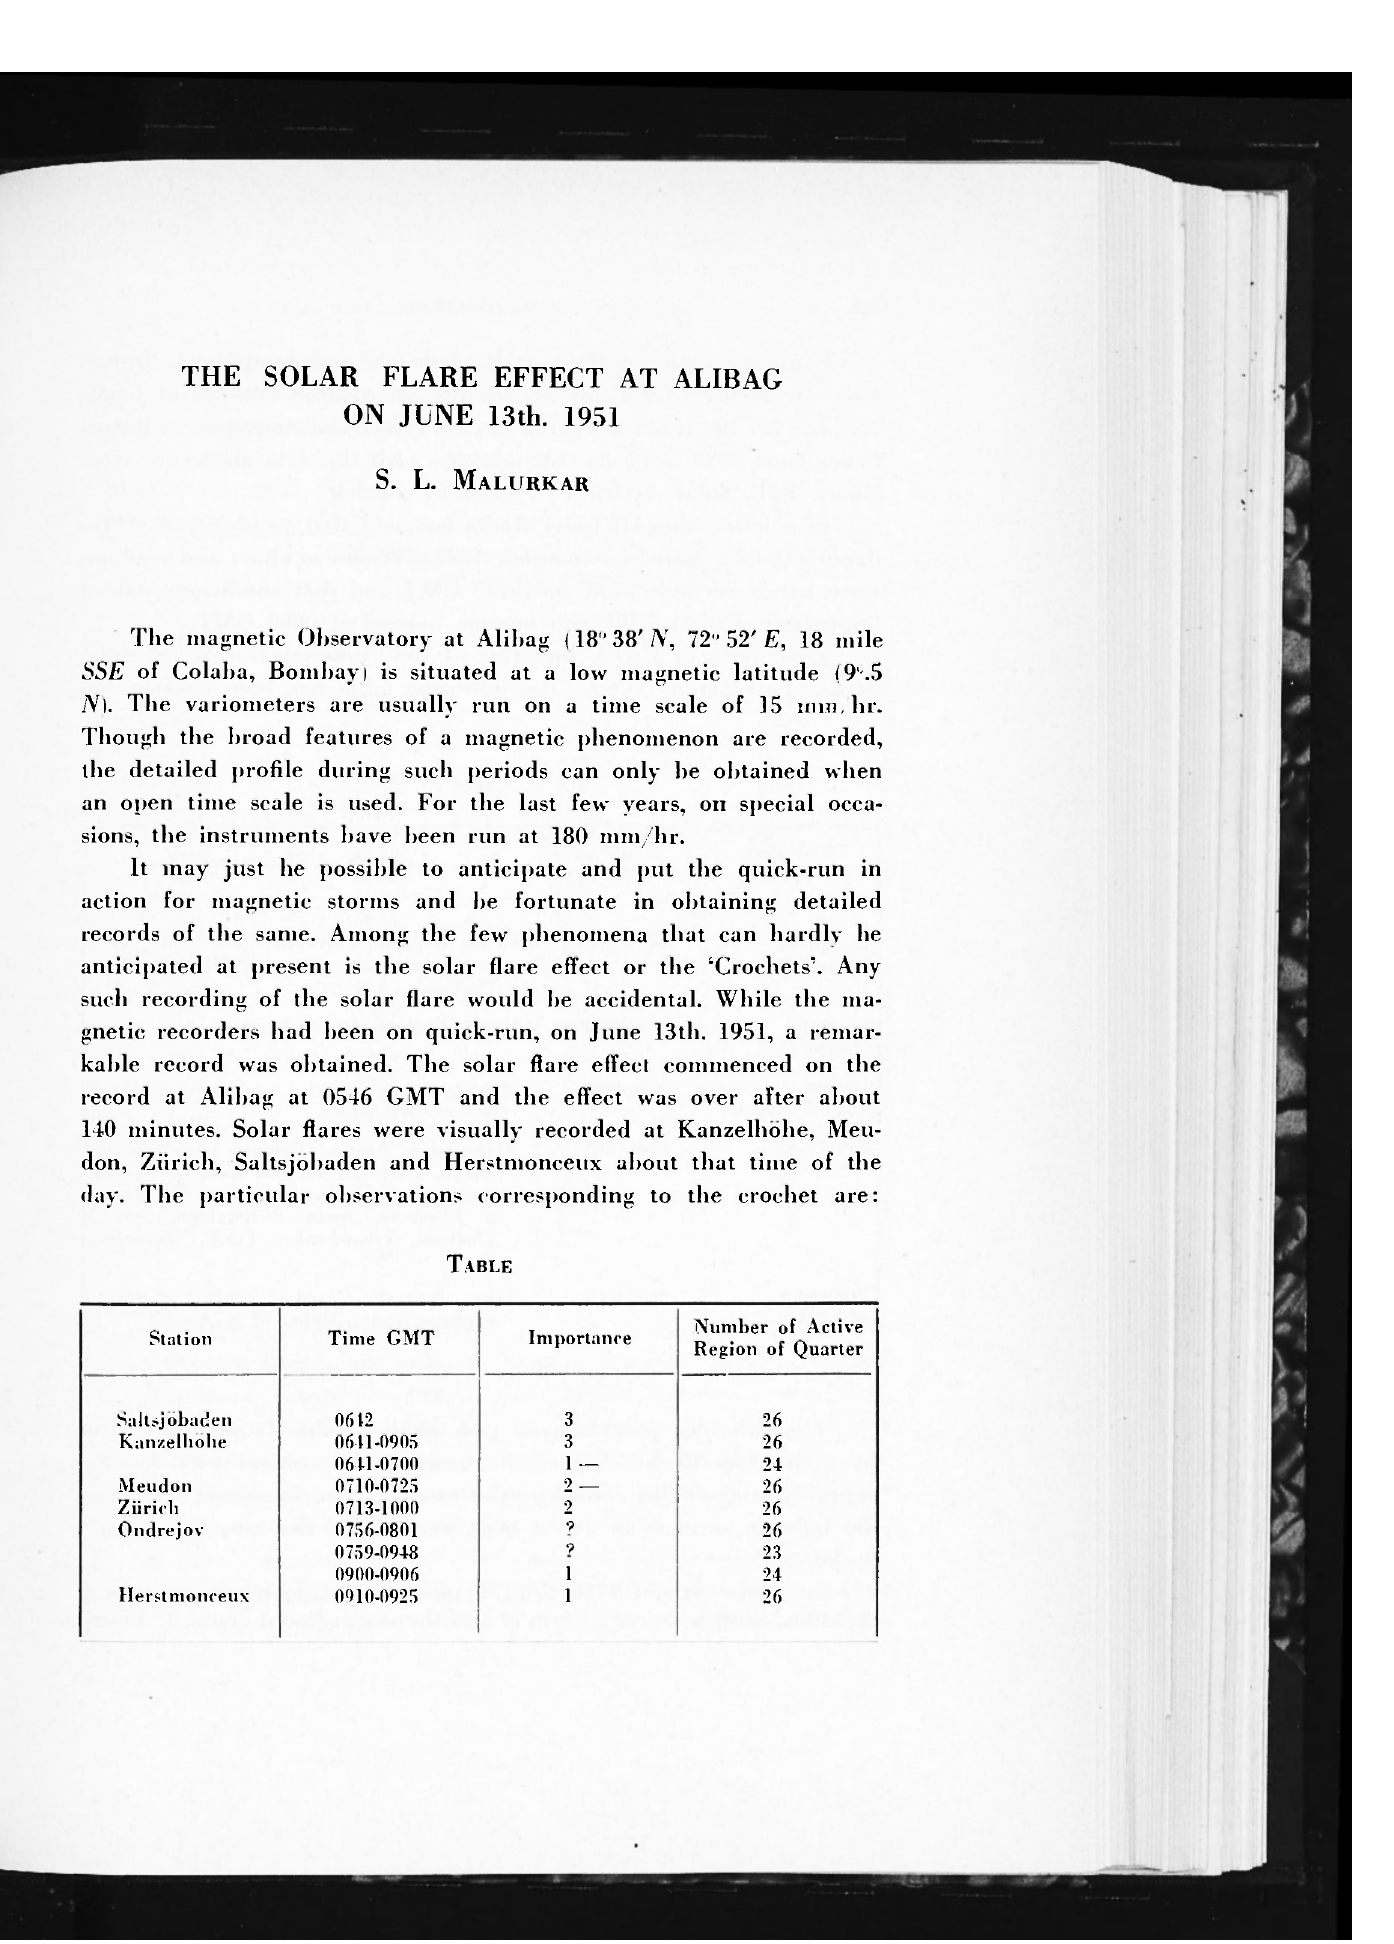
Number of Active Region of Quarter